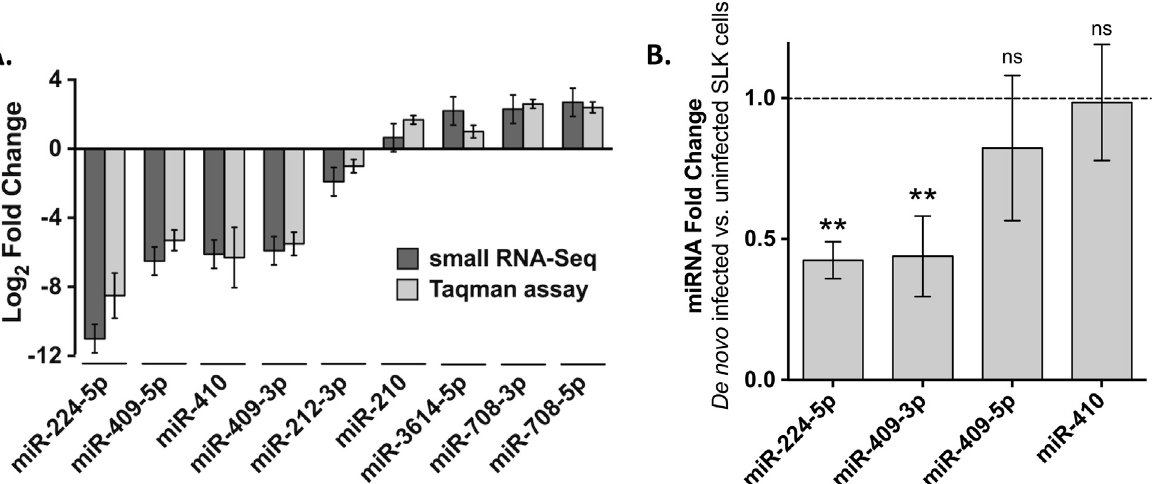
Fig 3. Analysis of miRNA expression in latent and de novo KSHV-infected cells. A. Data represent the average log 2 -transformed fold change of expression between latently infected SLKK cells and uninfected SLK cells, measured either by small RNA sequencing (black bars) or Taqman assay (grey bars). All the changes are significant ( P (cid:3) 0.05) except that of miR-210 as detected by miRNA-Seq. B. Effects of de novo KSHV infection on miRNAs seen down-regulated in the SLK/SLKK model. SLK cells were exposed to KSHV and after 5 days, changes in specific miRNAs were assessed by Taqman assay. The dotted line indicates the normalized level of these miRNAs in uninfected SLK cells. P-values were calculated using Student t-test. ** indicates P < 0.01. ns: not significant. Expression levels of mature miRNAs were evaluated using the comparative CT method (2-deltaCT). Transcript levels of RNU43 were used for sample normalization. Bars depict the mean of 3 independent experiments; error bars reflect the standard deviation.